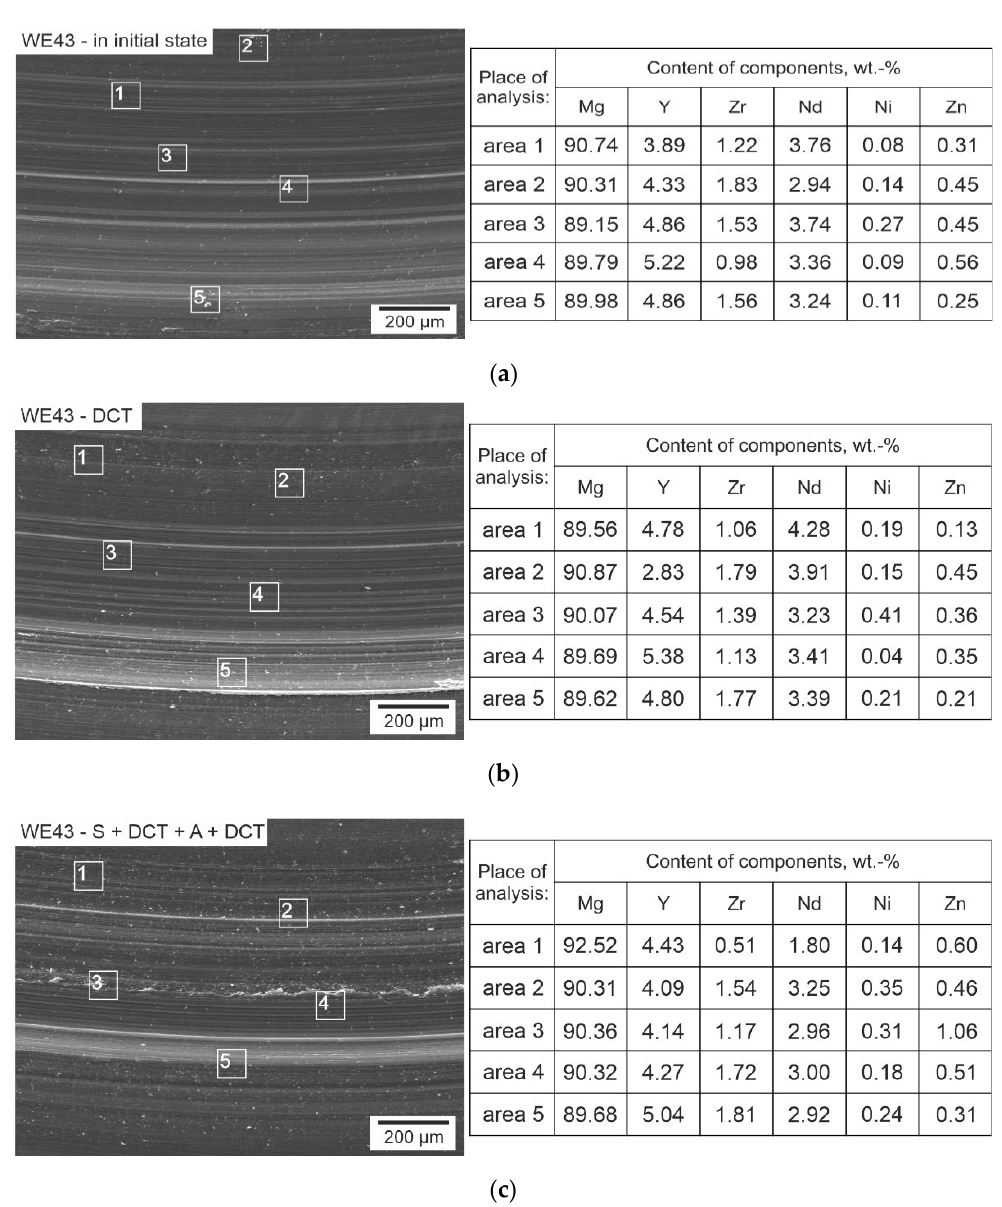
10 of 15 Figure 10. Linear wear, L w —( a ) mean stabilized friction coefficient, µ mean —( b ) of WE43 alloy in the initial state and after different heat treatment variants. The error bars in the figures represent a standard deviation ( σ Lw = 1.32–6. 82 µ m; σ µmean = 0.046–0.064 ) . The analysis of the results linear wear L w (Figure 10 a) confirms a significant reduction of this type of wear for the WE43 alloy subjected to sub-zero treatment at −1 96 °C/24 h, after solution treatment at 545 °C/ 8 h , and after aging for 24 h. The alloy in the initial state was characterized by linear wear of L w = 92.4 µm, while the treatment that was carried out allowed for reducing this value by more than 53%, to 43 µm. The mean stabilized coeffi- cient of dry friction, µ mean , in rotary motion for the friction couple ZrO 2 ball/WE43 alloy (Figure 10 b) oscillat ed around µ mean = 0.48 for the samples in the initial state. Lower values were recorded for samples after sub-zero treatment and after solution treatment combined with sub-zero treatment, µ mean = 0.41, and µ mean = 0.44 after sub -zero treatment combined with precipitation hardening. The above results corroborate that increasing the amount of β -phase lamellar precipitates by introducing deep cryogenic treatment to the precipitation hardening process effectively reduces the tribological wear of the investigated alloy. Sim- ilar observations can be found in the literature in works on magnesium alloys with alu- minium [16,21] and gadolinium [22–26] additions, and in our previous papers concerning WE54 magnesium alloy [27,28 ]. The results of microanalysis of the chemi cal composition (EDS) of the wear traces of the WE43 alloy shown in Figure 11 confirm that the applied heat treatment and the friction